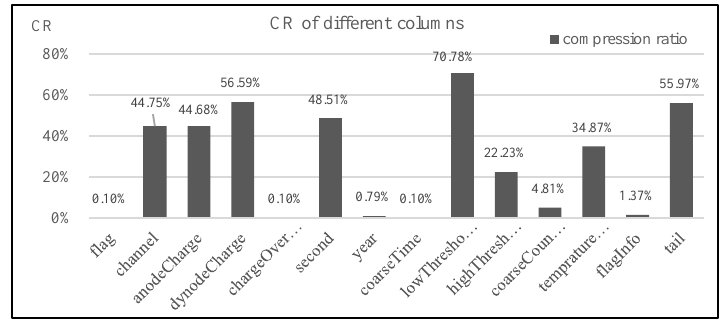
“lowThresholdFineTime” has the highest compression ratio, while column “lowThresholdFineTime” has the best compression